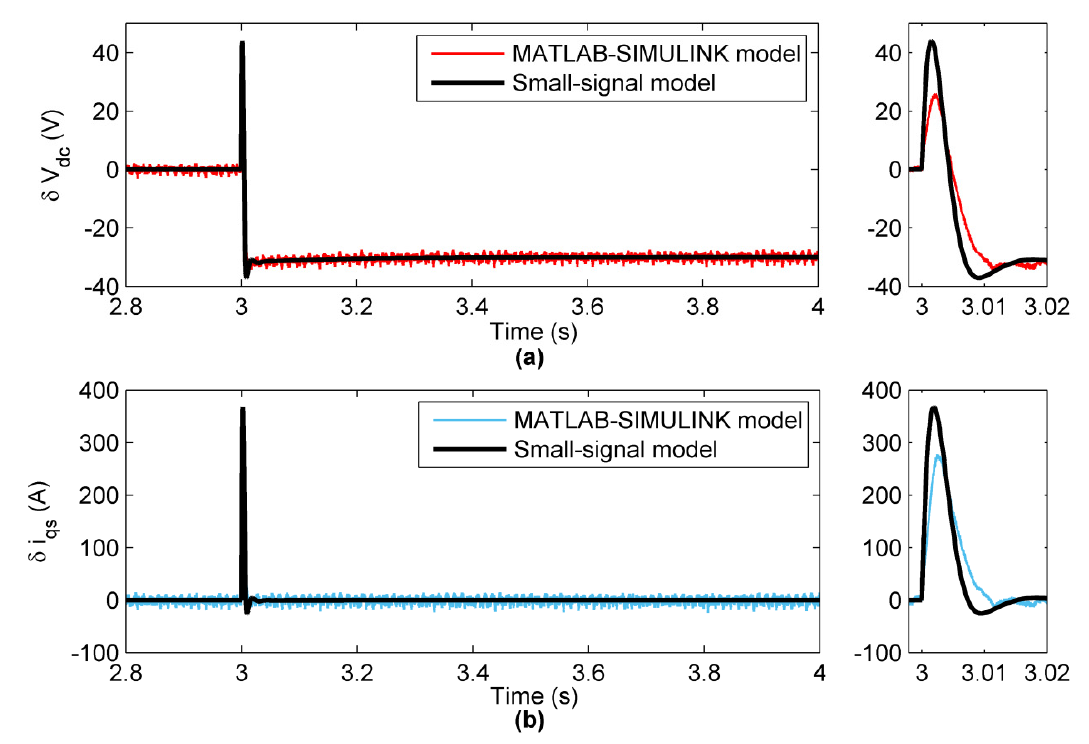
Figure 16. ( a ) The waveforms of dc-link voltage; and ( b ) the q-axis current of the generator ( δ i qs ) in 30 V voltage variation of δ V dc − ref .